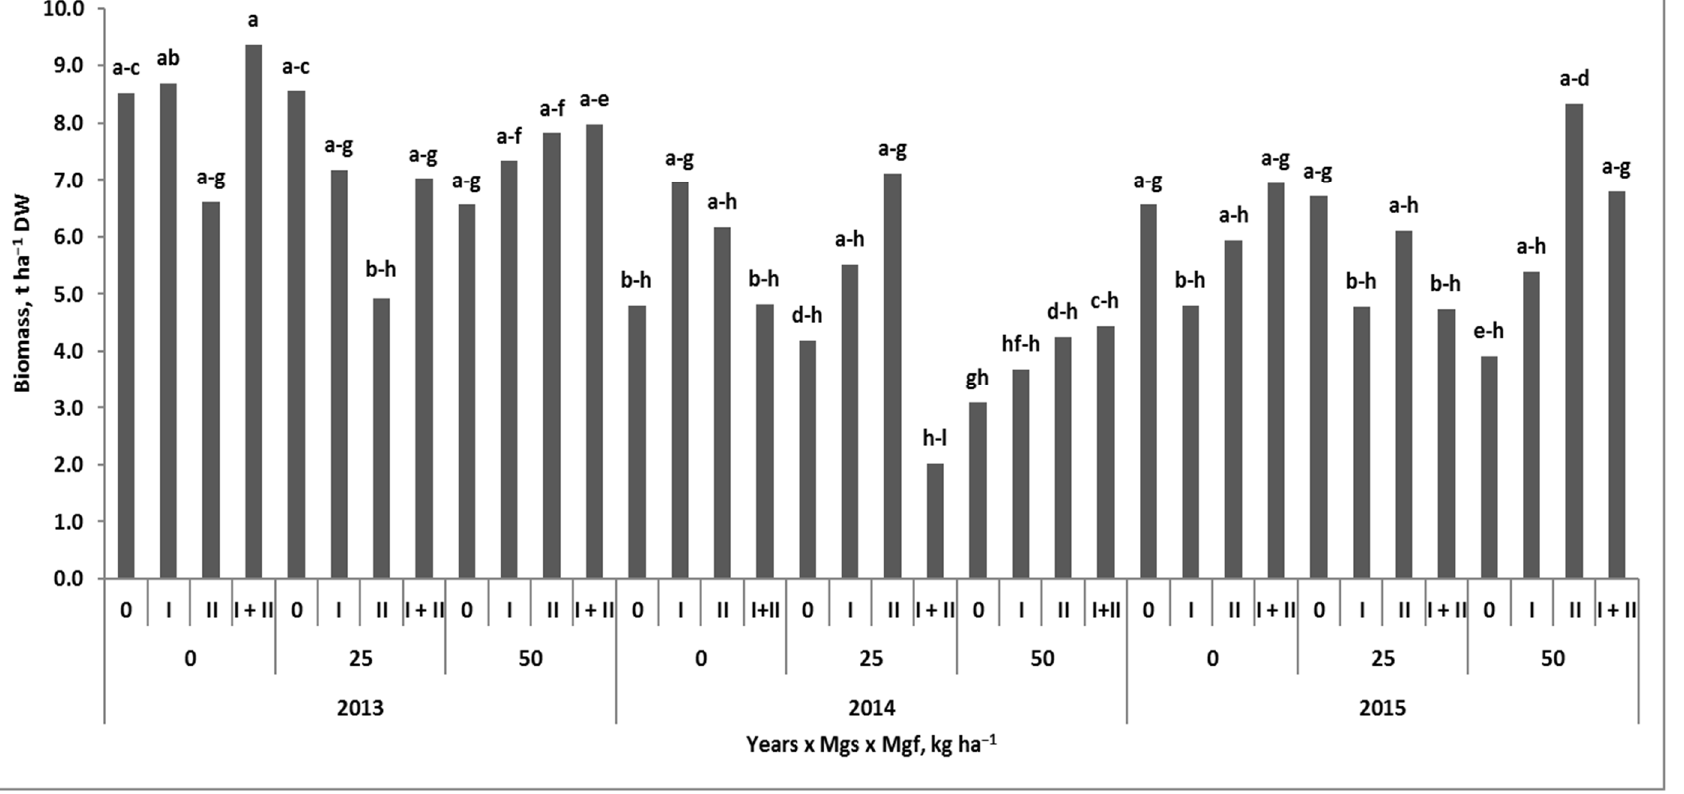
Figure 10. Effect of magnesium fertilization systems on the background of years on the remobilized dry matter of winter wheat in the maturation phase. Similar letters mean a lack of significant differences using Tukey’s test. Legend: Mgs, Mgf—soil and foliar Mg fertilization systems, respectively; I—BBCH 30; II—BBCH 49/50.